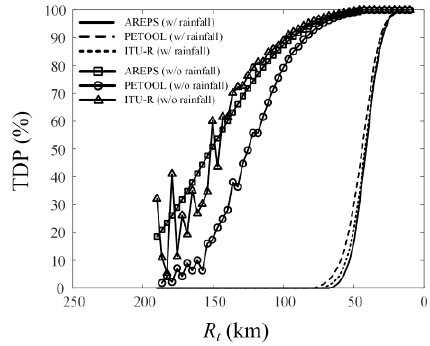
Figure 10. Comparison of TDP along the range using different propagation models for the third scenario.